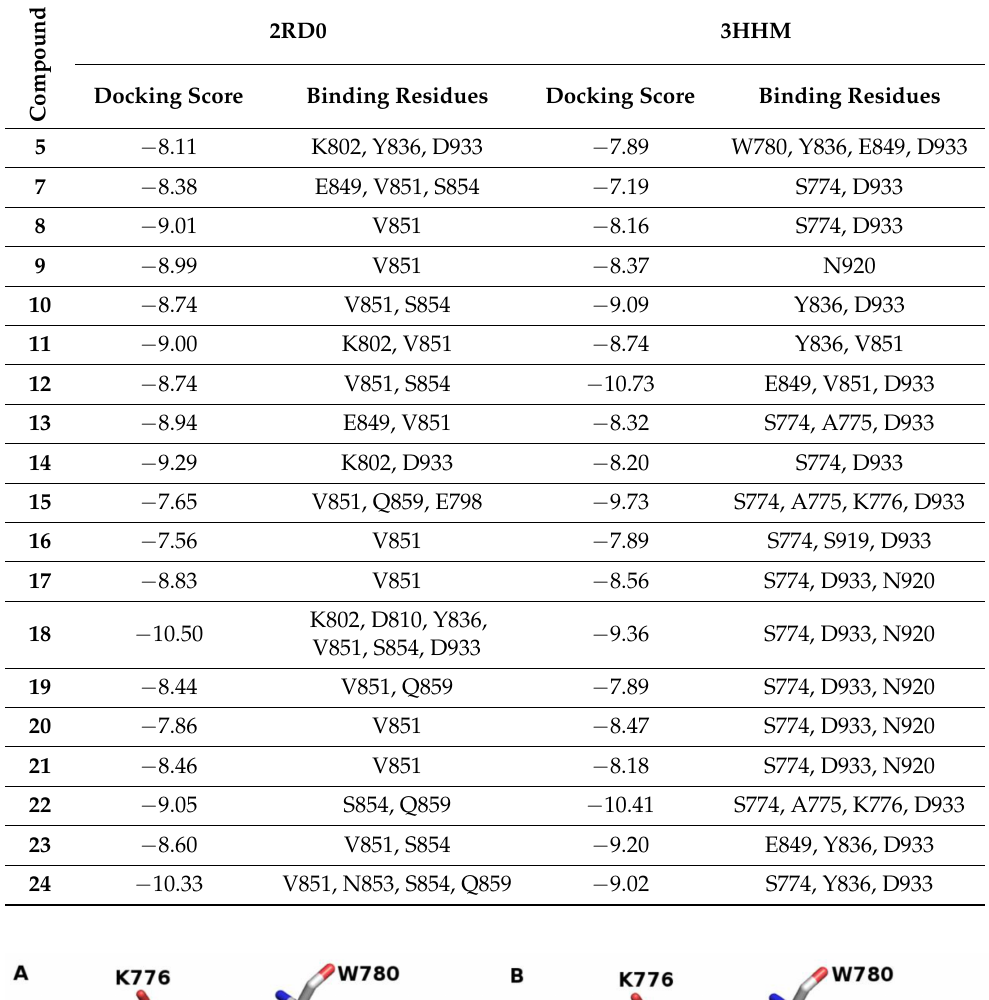
Table 3. Induced-fit docking (IFD) scores (Kcal/mol) and H-bond interactions against wild-type (WT) (2RD0) and mutant (MUT) (3HHM) PI3K α .